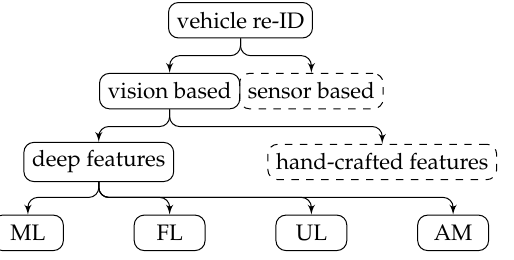
Figure 2. Categories of vehicle ReID methods. Dashed boxes represent methods that are not detailed. Table 2. Vehicle ReID methods based on deep-features